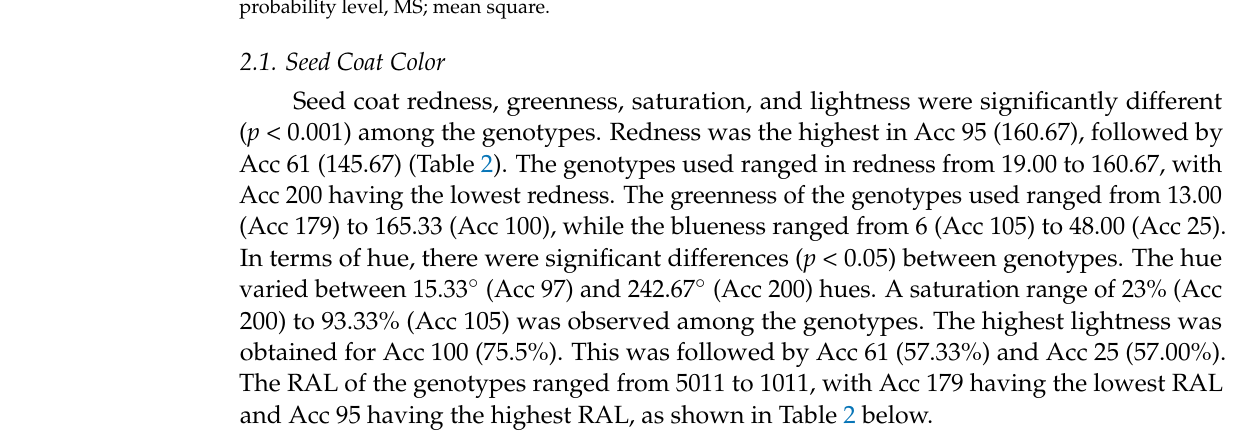
Table 2. Seed coat color among twenty-four Bambara groundnut